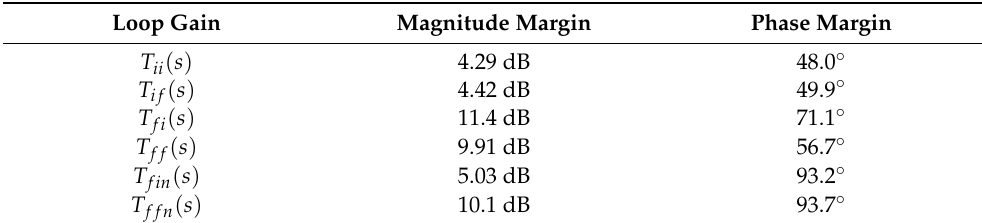
Figure 11. Bode plots of approximated fractance chain circuits: ( a ) s 0.9 ; ( b ) s − 0.9